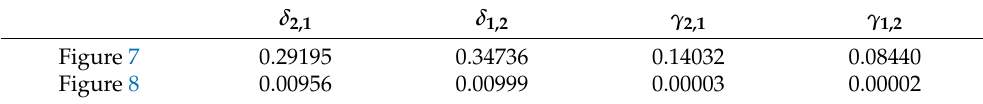
Table 1. Desired and undesired displacements of design results shown in Figures 7 and 8.